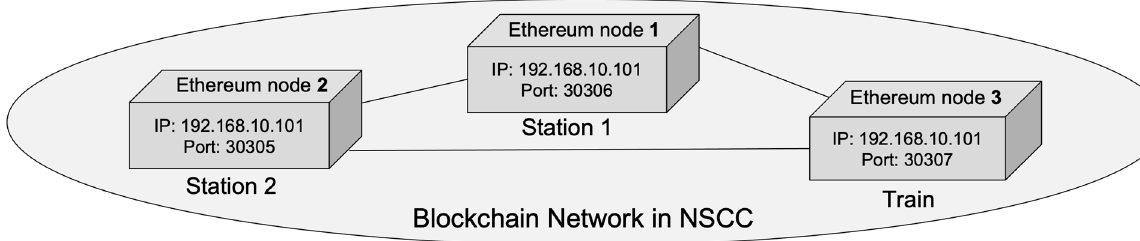
Figure 9. Blockchain network in NSCC using Docker, SUMO, and Ethereum.